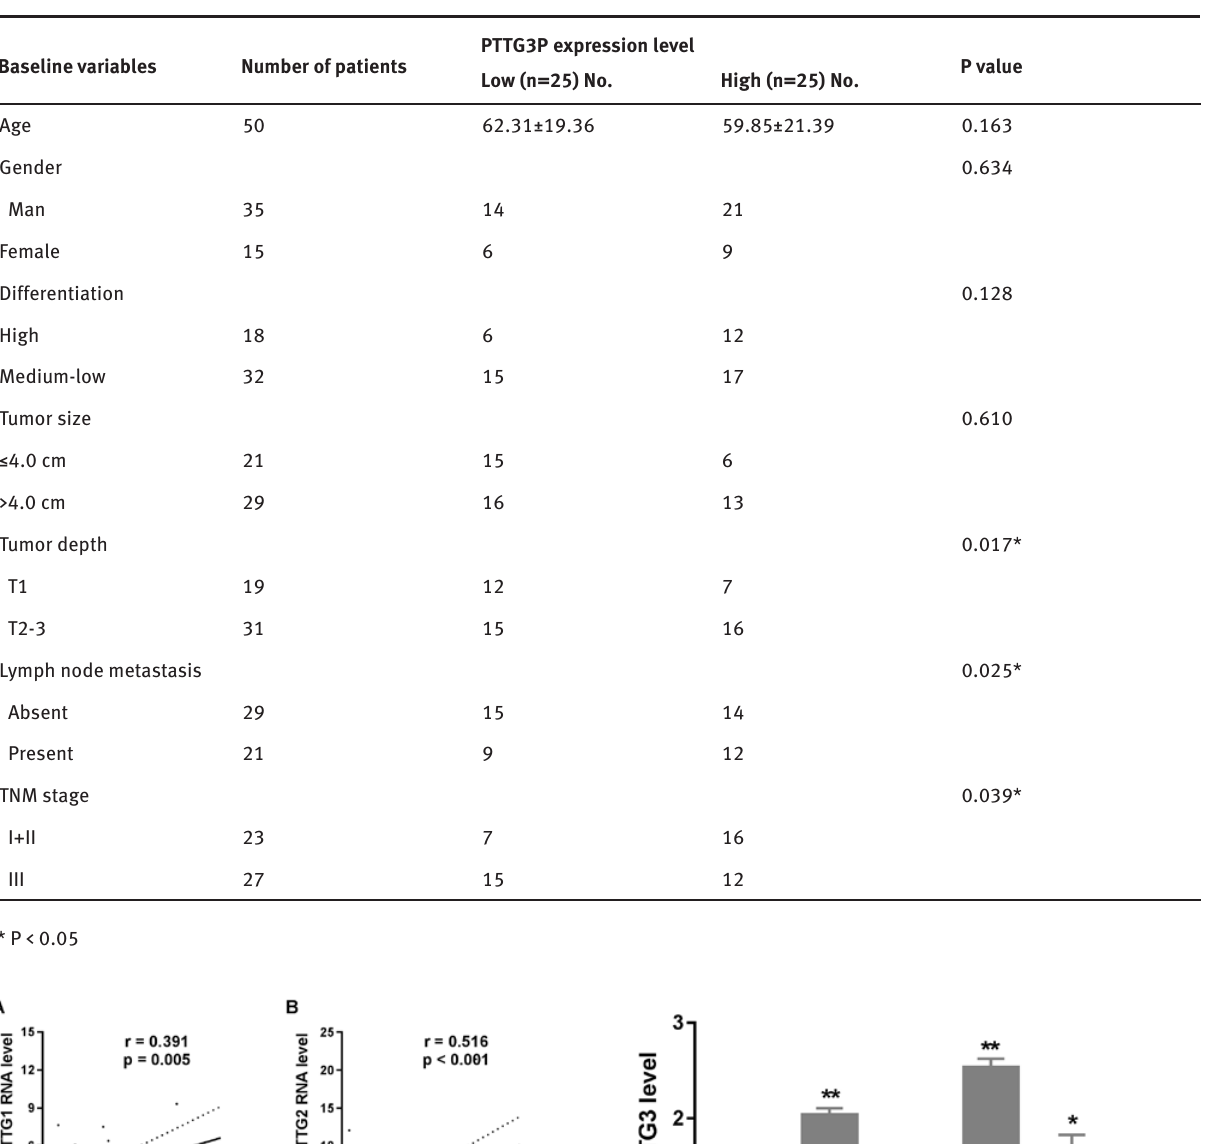
Table 1: Relationship between PTTG3P expression and clinicopathological features of ESCC